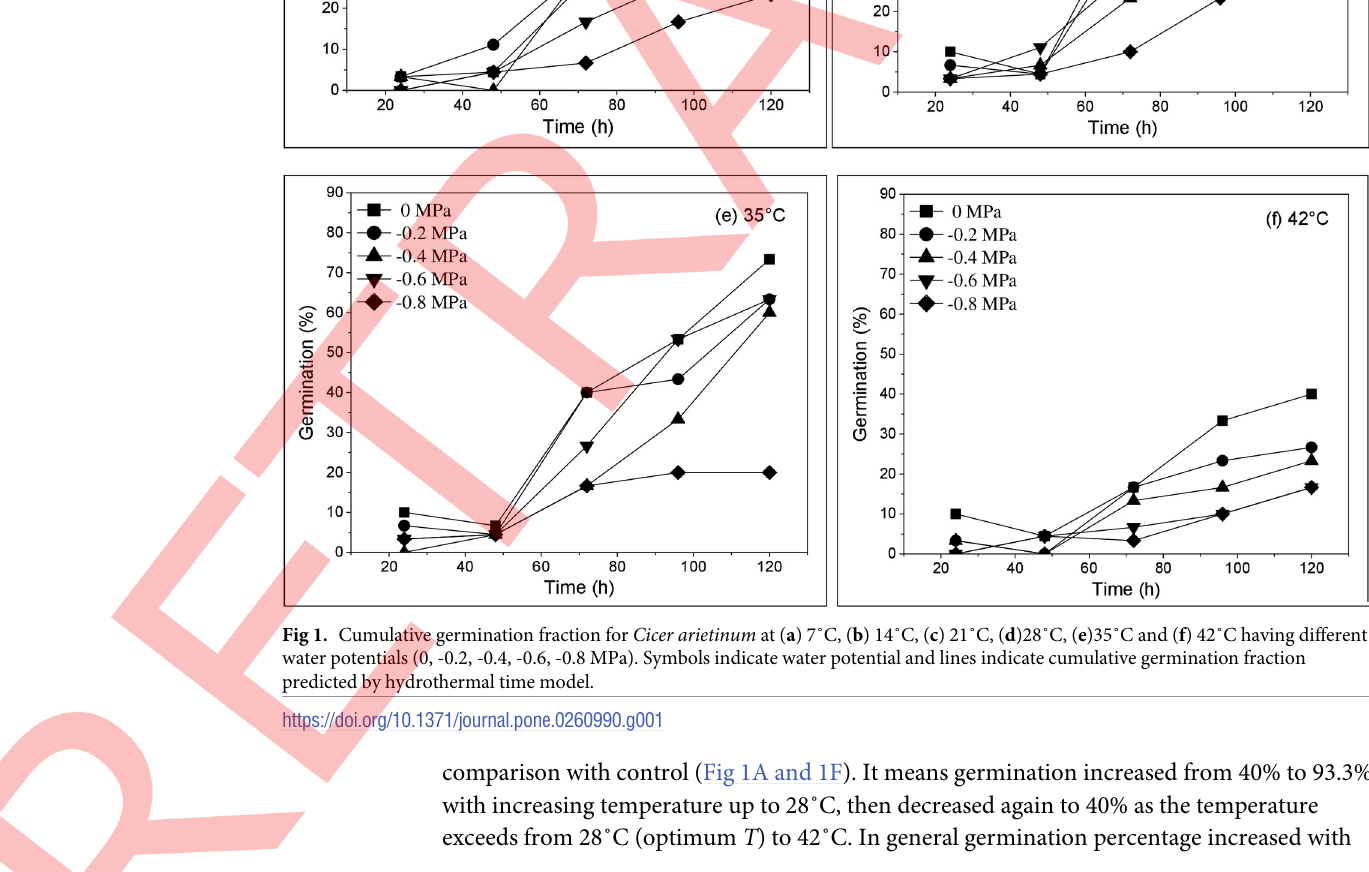
comparison with control (Fig 1A and 1F). It means germination increased from 40% to 93.3% with increasing temperature up to 28˚C, then decreased again to 40% as the temperature exceeds from 28˚C (optimum T ) to 42˚C. In general germination percentage increased with